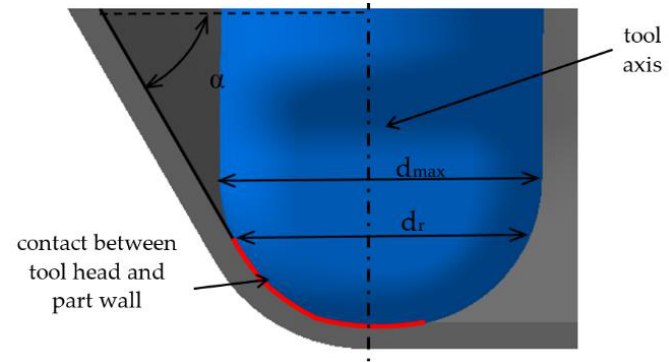
Figure 6. Difference between the largest diameter, d max and the real contact diameter, d r .